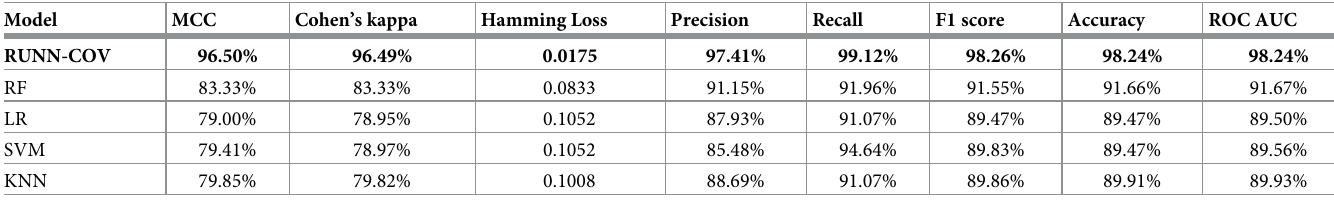
Table 2. Performance comparison with traditional ML models.